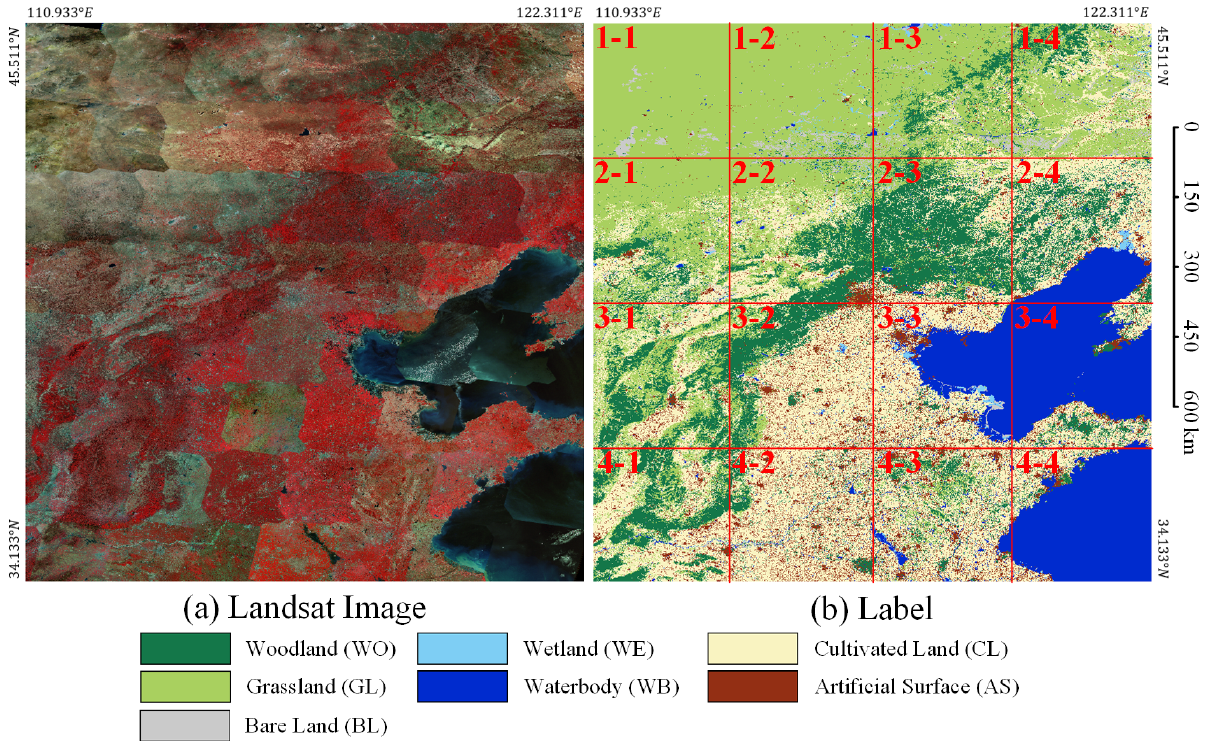
Figure 8. Geographical distribution of Landsat core dataset and Landsat extend dataset in Region N. LSC dataset IDs: 2-2, 2-3, 3-2, 3-3. LSE dataset IDs: 1-1, 1-2, 1-3, 1-4, 2-1, 2-4, 3-1, 3-4, 4-1, 4-2, 4-3, 4-4. ( a ) Landsat images. ( b ) Labels.